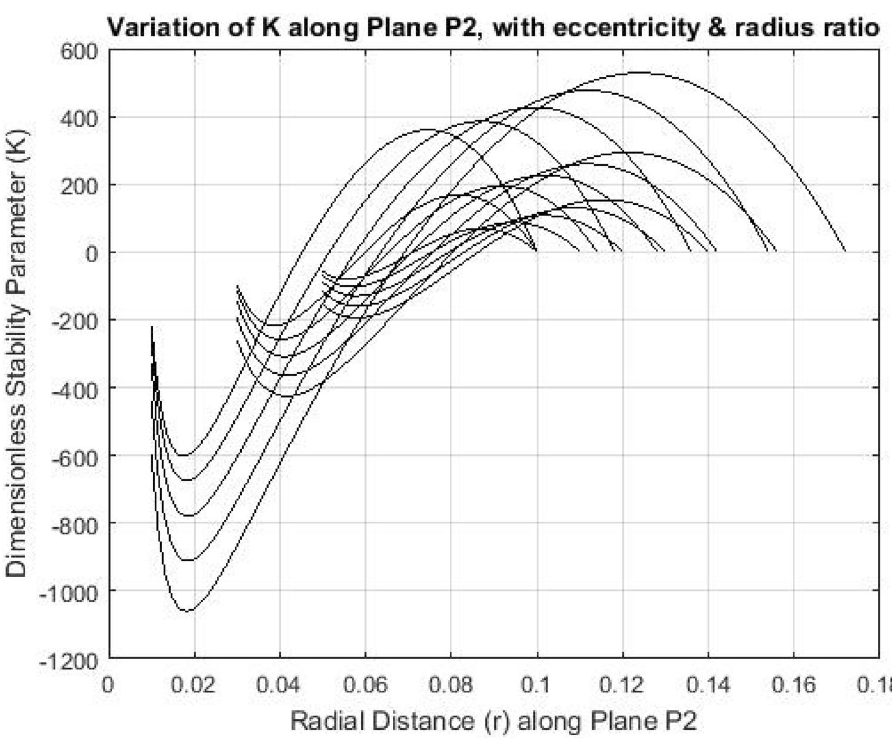
Fig. 4 Effect on K with varia- tion in r , k and ɛ along plane P